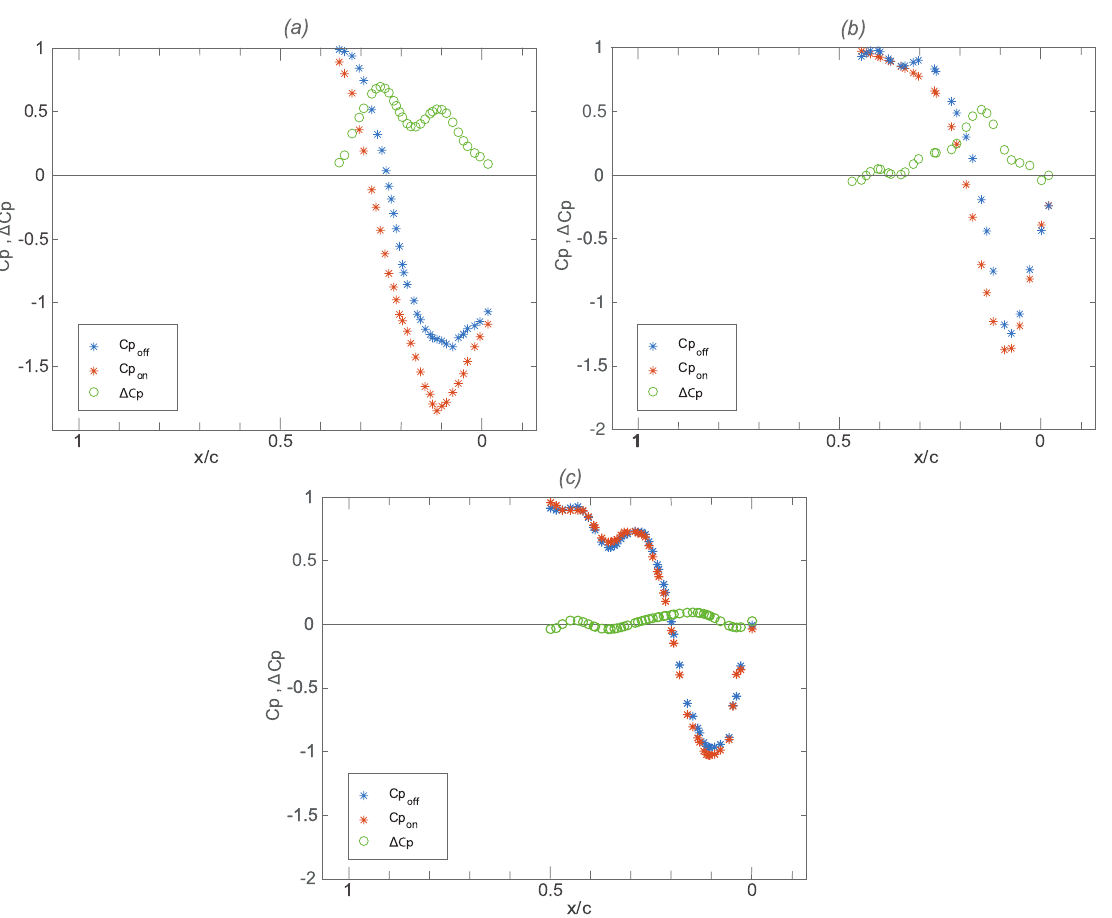
Figure 21. C P values at ( a ) T A , ( b ) T B , and ( c ) T C for α = 14.5 ◦ and U ∞ = 30